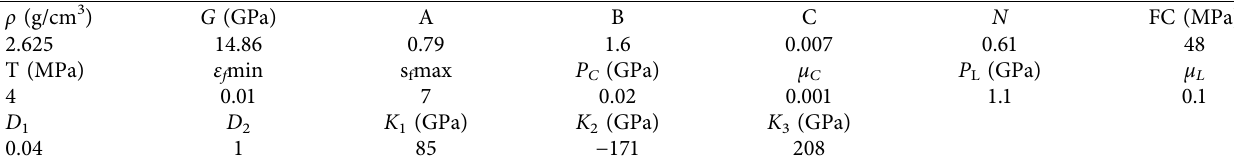
Table 3: Material parameters of the concrete